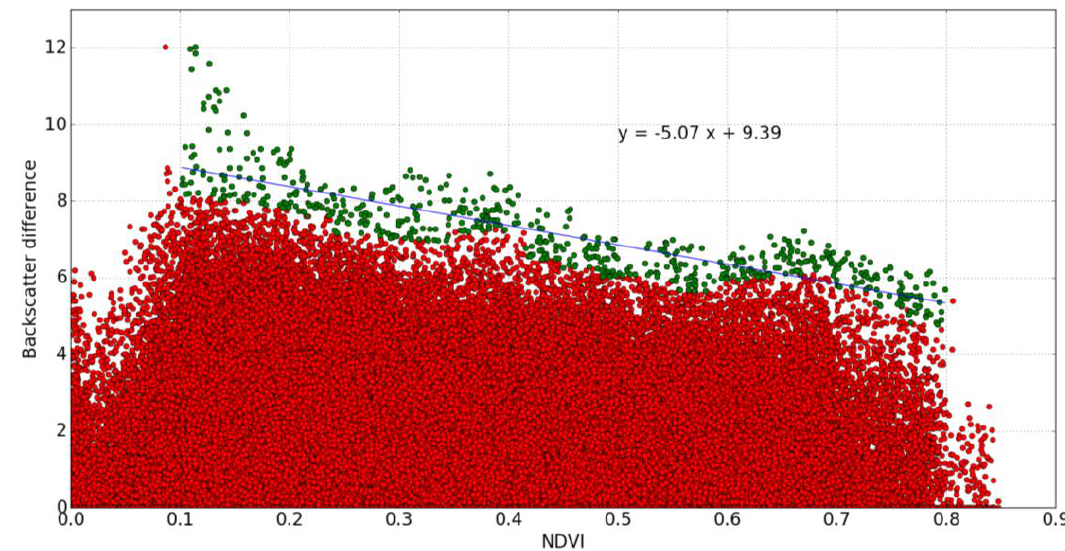
Figure 4. Illustration of the processed radar signal differences (dB) for all dates, with the driest radar signals shown as a function of NDVI for all (100 m × 100 m) cells in the Urgell area. Each point corresponds to a single radar signal difference ∆ σ NDVI for a cell (i,j).